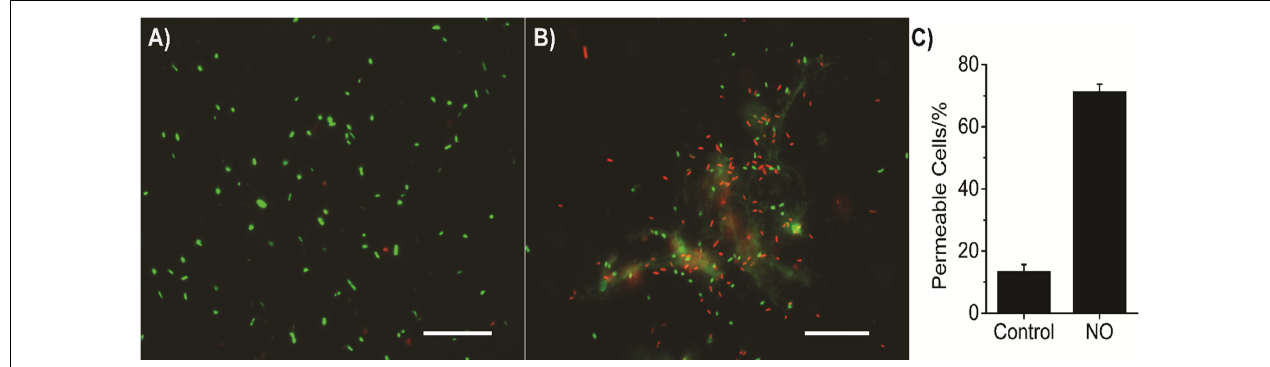
FIGURE 6 | Representative images of P. aeruginosa biofilm released cells staining with Live/Dead BacLight TM Bacterial Viability kit (L7012, ThermoFisher Scientific, Waltham, MA, USA). Biofilm released cells were stained with two fluorescent dyes, SYTO-9 and propidium iodide (PI), according to its instructions. Bacterial cells with intact membrane stain with SYTO-9 showing green fluorescent light, while cells with impaired membrane stain with PI showing red fluorescent light. (A) Bacteria with no NO release treatment; (B) Bacteria with 3 h NO release treatment; (C) Summary of the percentage of permeable cells (red fluorescence), error bars indicate the standard deviation of measurements from different images. The scale bars in (A,B) are 20 µ m.